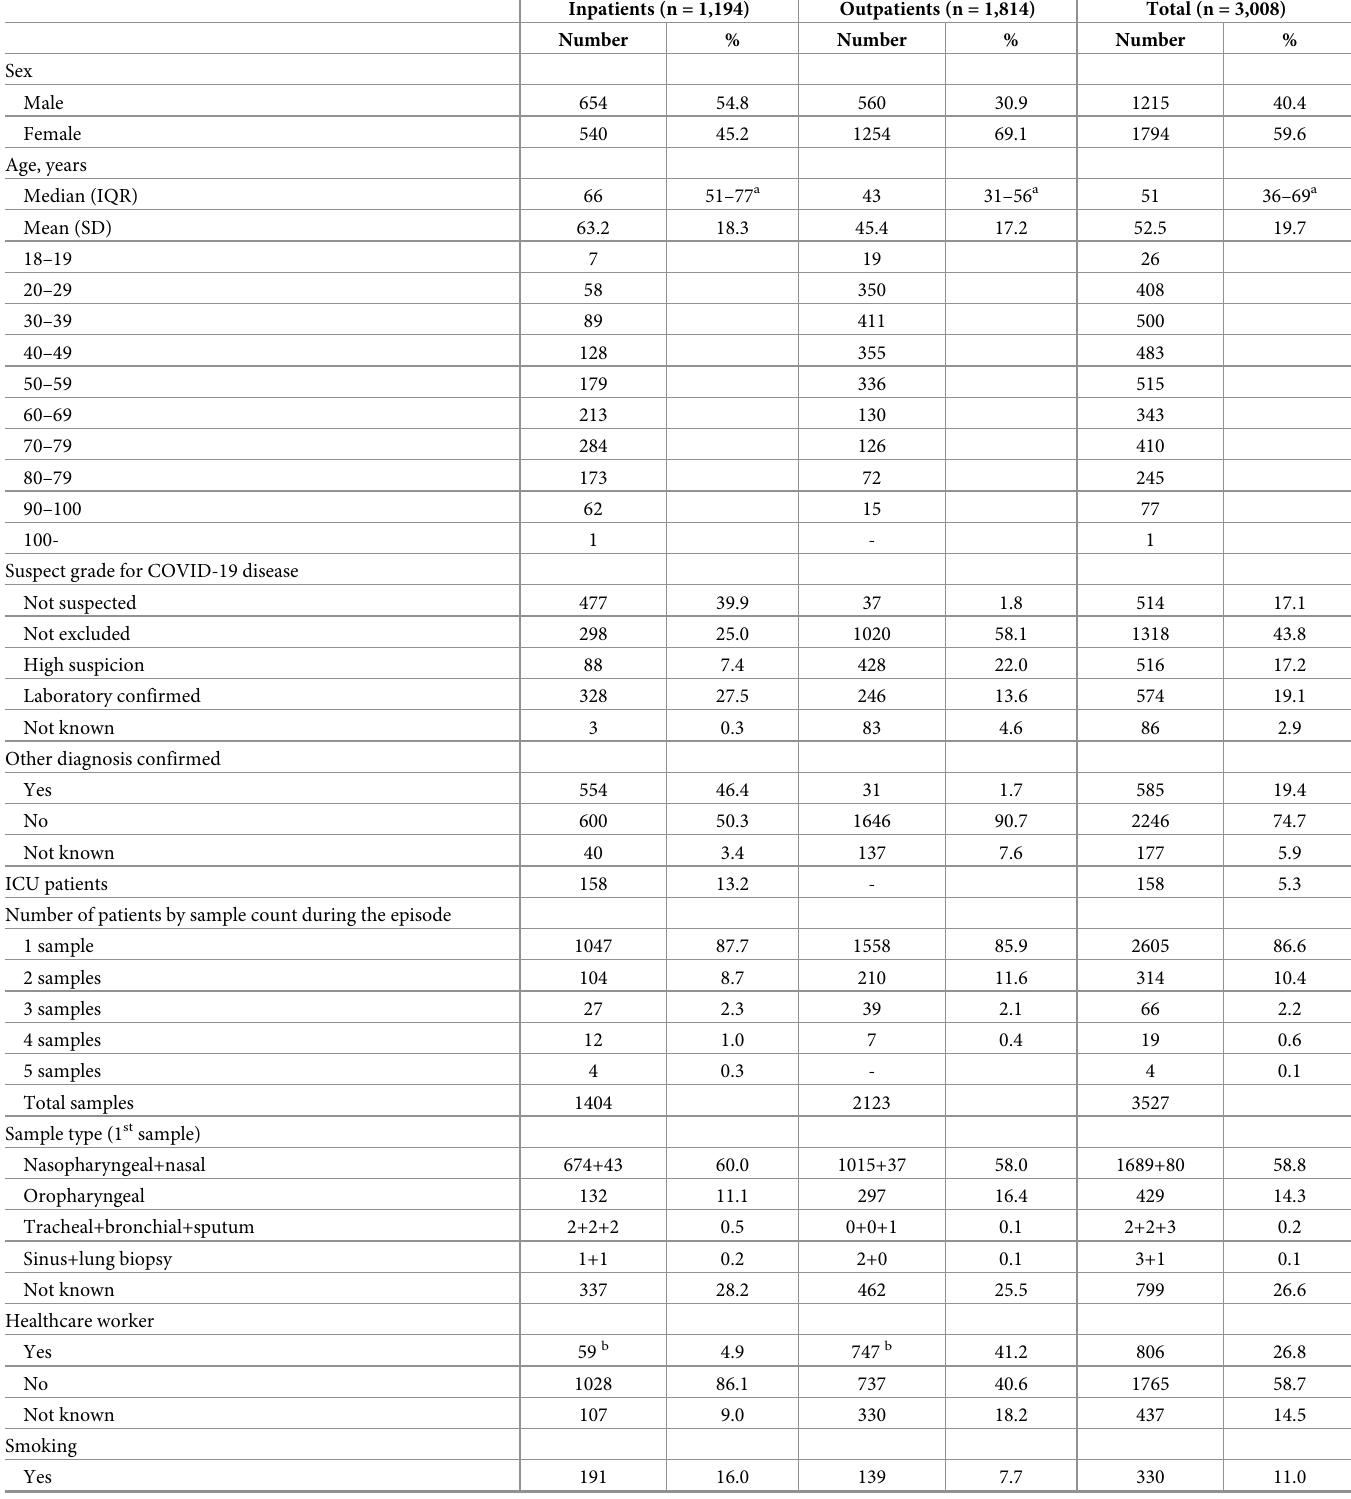
Table 1. Patient demographic and clinical